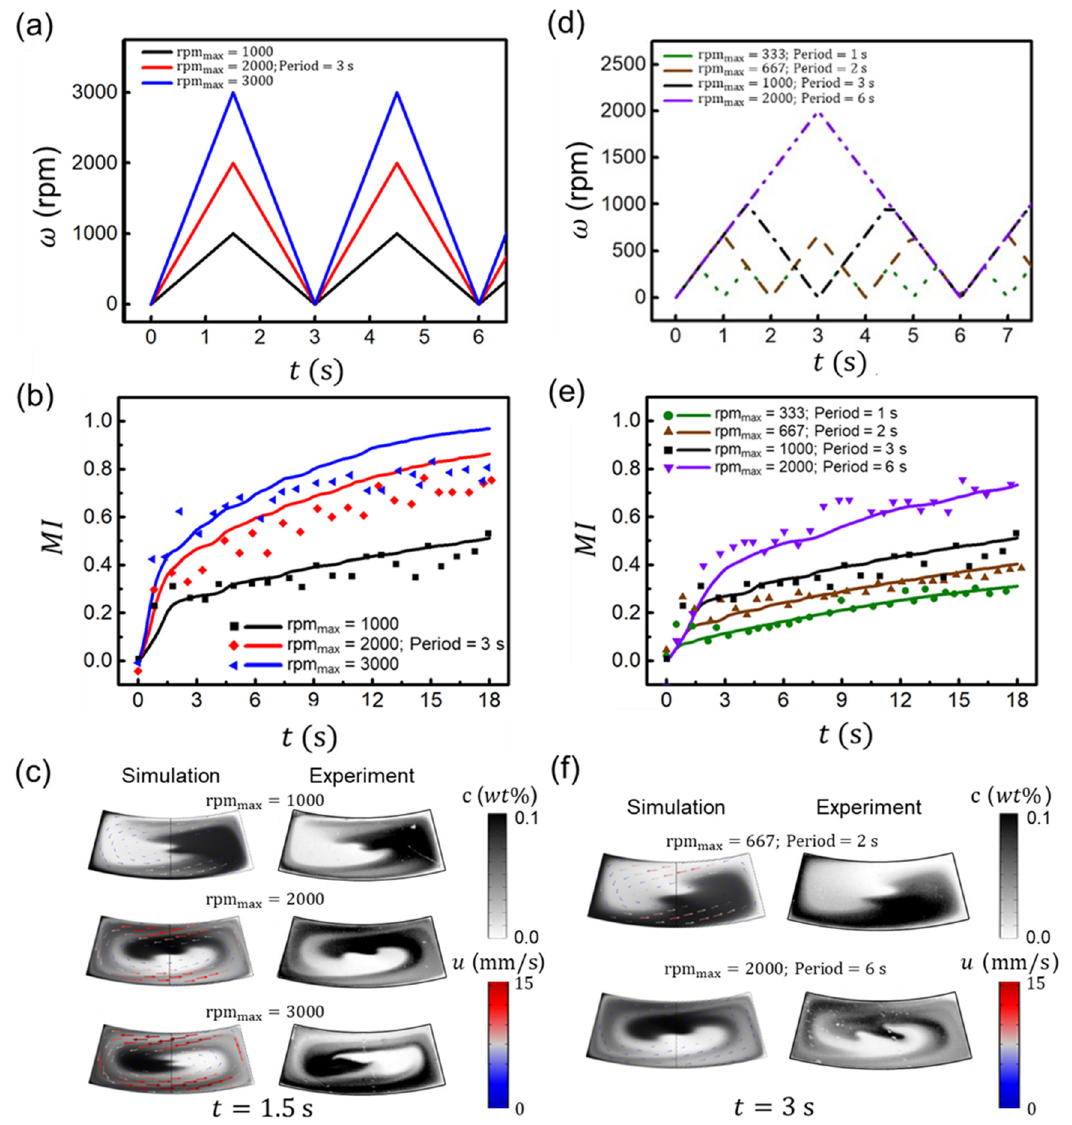
Figure 3. Mixing behaviors with various rotational conditions. Case 1 ( a – c ): ( a ) Triangular waveform of rotational velocity of ω for maximum speeds of 1000, 2000, and 3000 rpm with a constant period of 3 s. ( b ) Mixing index for the simulation (solid line) and experiment (dots), with the conditions of ( a ). ( c ) Concentration comparison between the simulation and experiment at 1.5 s for the maximum rpm of 1000, 2000, and 3000 rpm. The arrows in the simulation images depict the velocity vectors. Case 2 ( d – f ): ( d ) Triangular waveform for the rotational periods of 1, 2, 3, and 6 s with maximum angular velocities of 333, 667, 1000, and 2000 rpm, respectively. ( e ) Mixing index for the simulation (solid line) and experiment (dots), with the conditions of ( d ). ( f ) Concentration comparison between the simulation and experiment at 3 s for rpm max = 667 with a period of 2 s and rpm max = 2000 with a period of 6